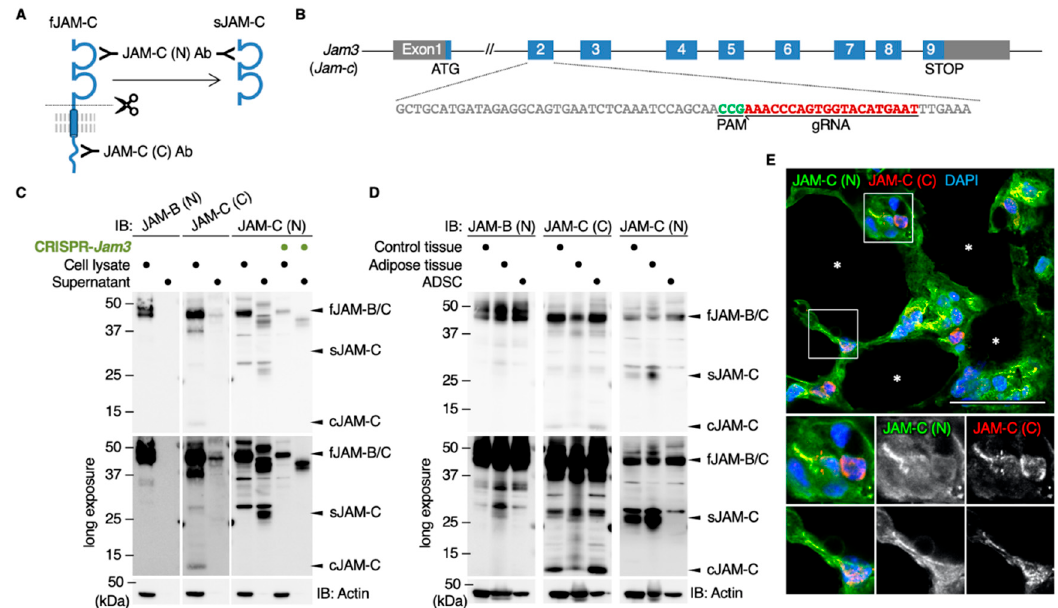
Figure 4. The cleaved JAM-C ectodomain is accumulated in the fat interstitial tissues. ( A ) Schematic illustration for detecting full-length JAM-C (fJAM-C) and/or soluble JAM-C (sJAM-C) using JAM-C (N) and JAM-C (C) antibodies (Abs) targeting the N- and C-termini, respectively. ( B ) Knockdown of the Jam3 gene encoding mouse JAM-C in ADSCs using the CRISPR method. ( C ) Western blot for the indicated proteins in the whole-cell lysates and supernatants of the revealed ADSCs. ( D ) Western blot for the indicated proteins in the whole-cell lysates of mouse adult spleen tissue (control), adipose tissue and ADSCs. ( E ) Confocal images of mouse adipose tissue stained with JAM-C (N) and JAM-C (C) Abs. Asterisks indicate lipid droplets in differentiated adipocytes. Squares show the enlarged areas. Scale bar, 50 µm.